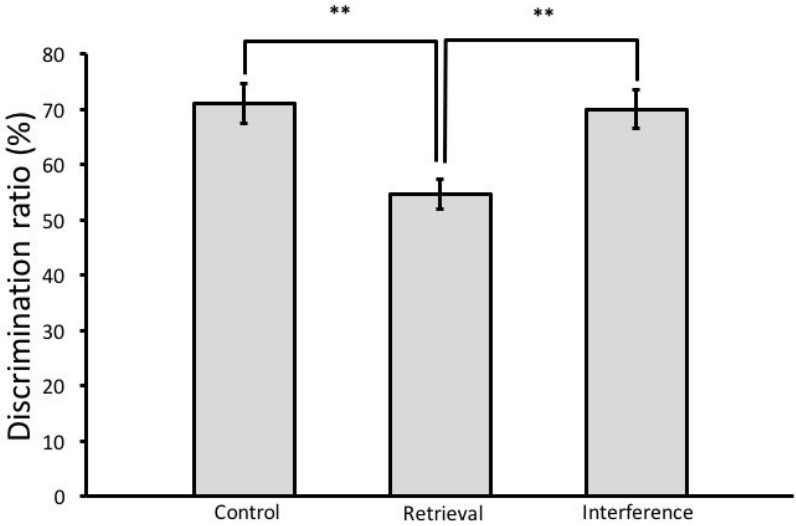
Figure 3. Discrimination ratio in the test phase (saline group). The discrimination ratio was calculated by dividing the total amount of exploration of the novel object by the total amount of object exploration. The retrieval group had significantly lower discrimination ratio than that of the control and the interference groups. Mean ± SEM is shown. ** p <